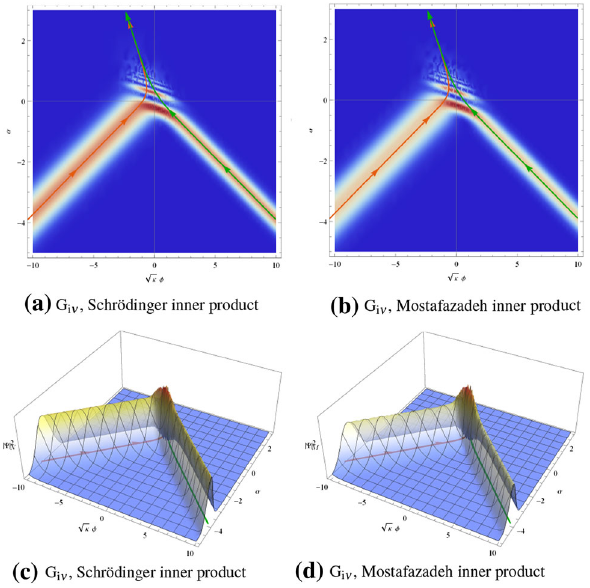
Fig. 3 Wave packets and the corresponding classical trajectories for the quintessence with m x V < 0. Parameters are V = + 1, λ = 4 / 5, ¯ ω = − 35 / 8 and Γ = 7 / 5